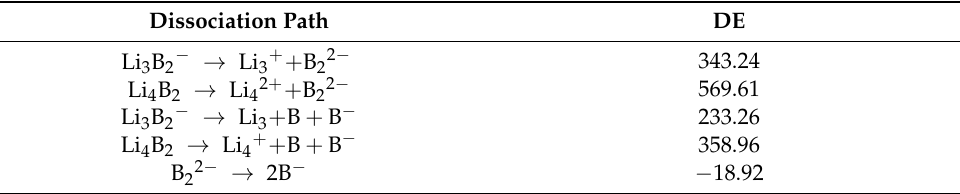
Table 1. Dissociation energies (DE, in kcal/mol) at the M06-2X/def2-TZVP level of theory.